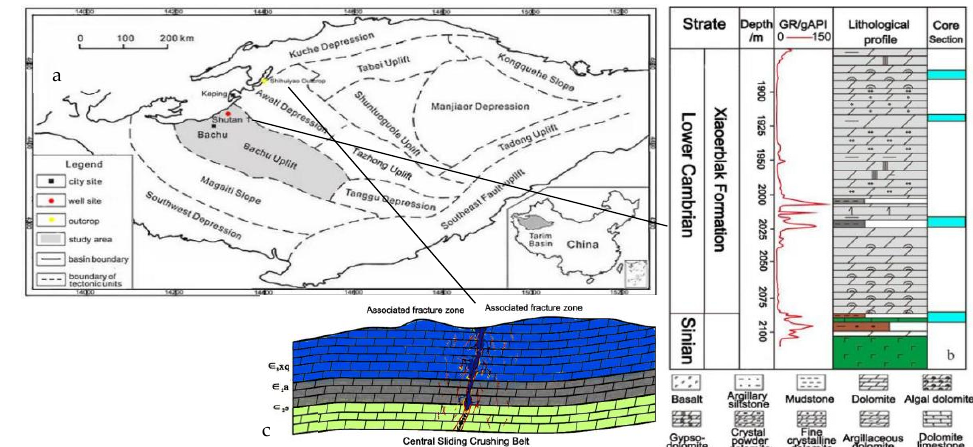
Figure 1. Geological setting of the study area: ( a ) location map of Bachu-Keping area in Tarim Basin; ( b ) lithological profile of Well Shutan 1; ( c ) tectonic cross-section of Shihuiyao